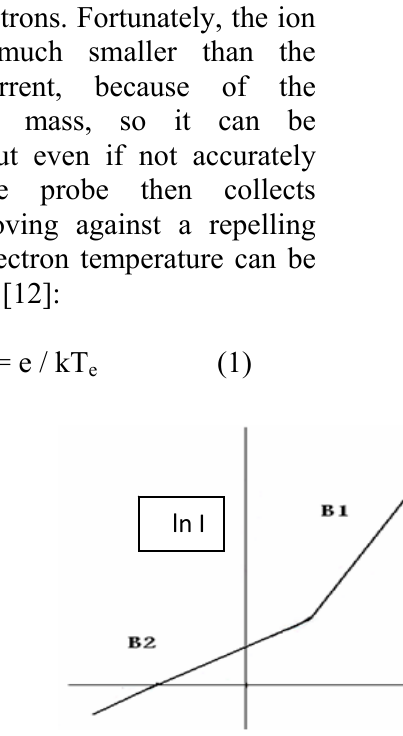
Fig.7: Schematic of ln I-V curve with a bend in the transition region, indicating the presence of two groups of electrons with different temperatures [13].